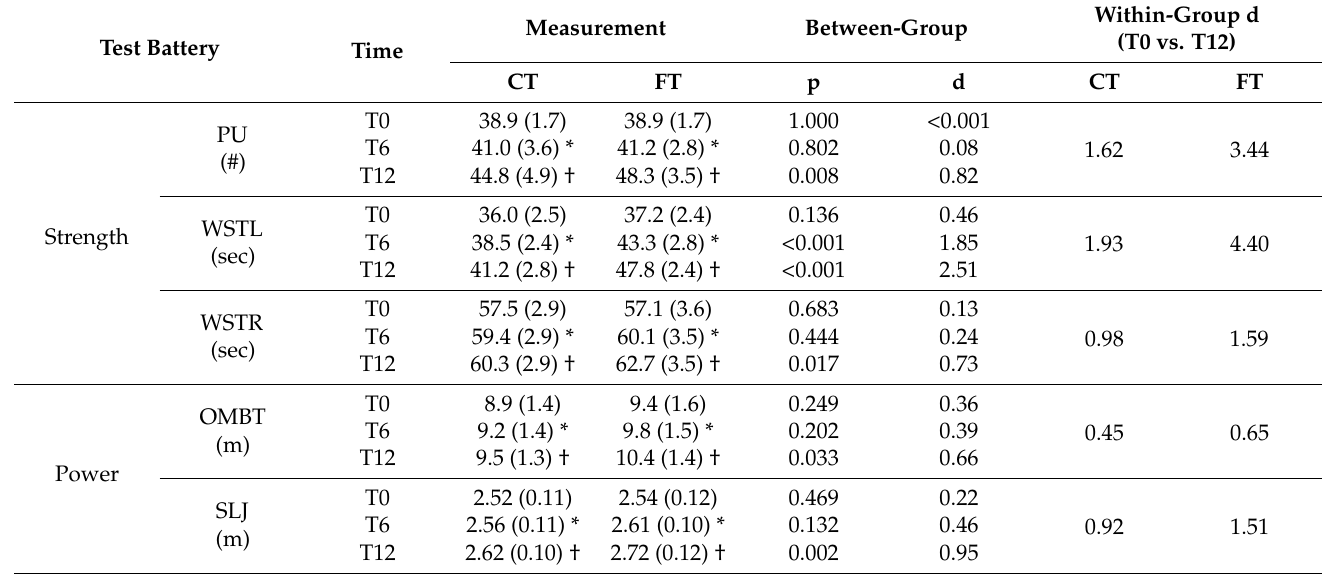
Table 3. Tennis-specific performance following 12-week